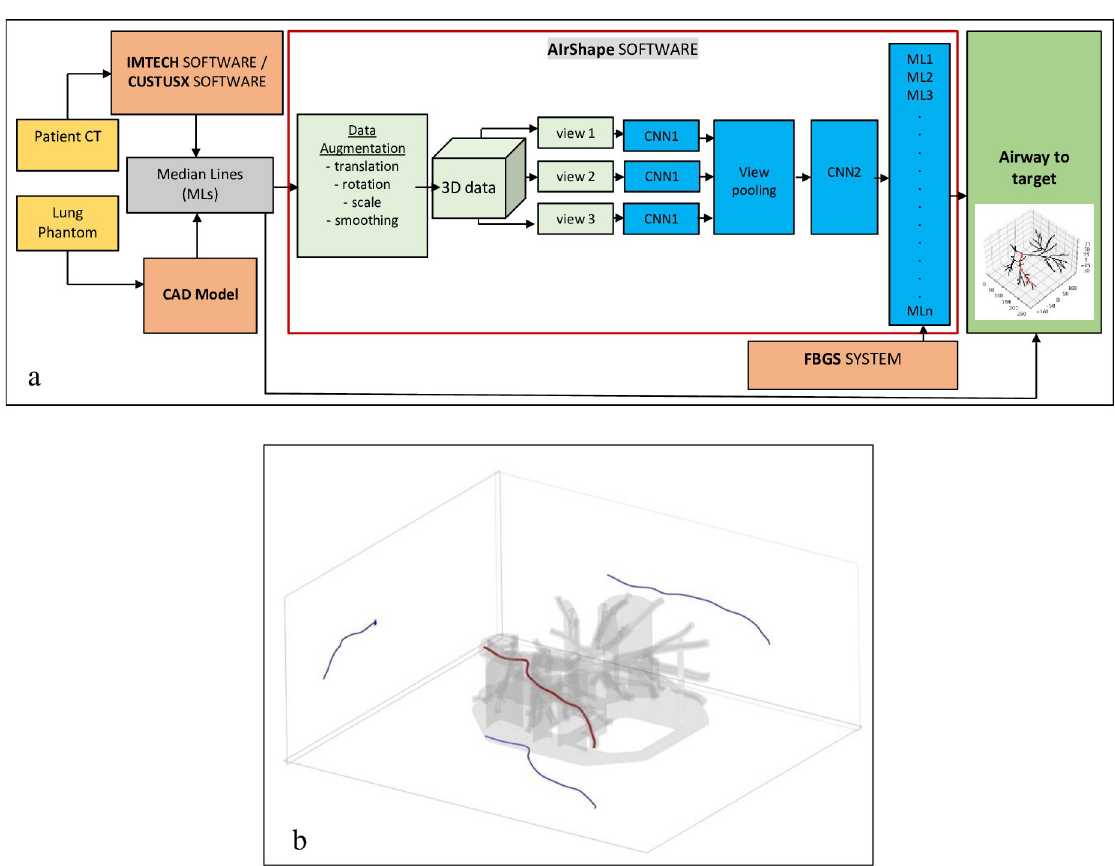
Fig 6. AIrShape MVCNN architecture and the complete navigation system data flow diagram from patient CT or lung phantom to median lines, AiRShape software and identification of airway trajectory to target (a), three orthogonal projections (views 1–3 above) computed for every median lines